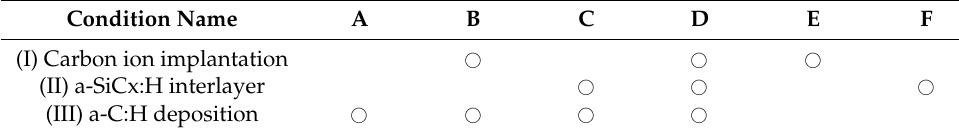
Table 2. List of deposition